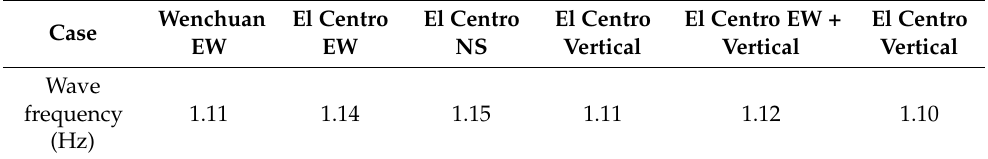
Figure 16. The free surface wave of the inner water. (El Centro EW case, t = 13 s). Table 4. The frequency of the inner water waves for different seismic vibrations.